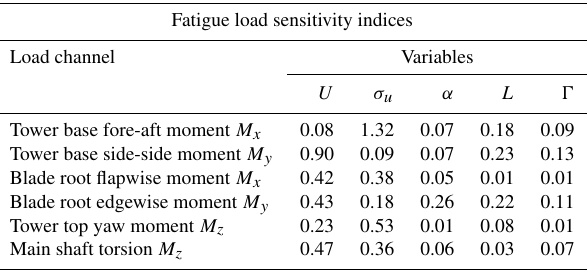
Table 4. Site-specific Sobol sensitivity indices derived for site 0 using MC simulation from a